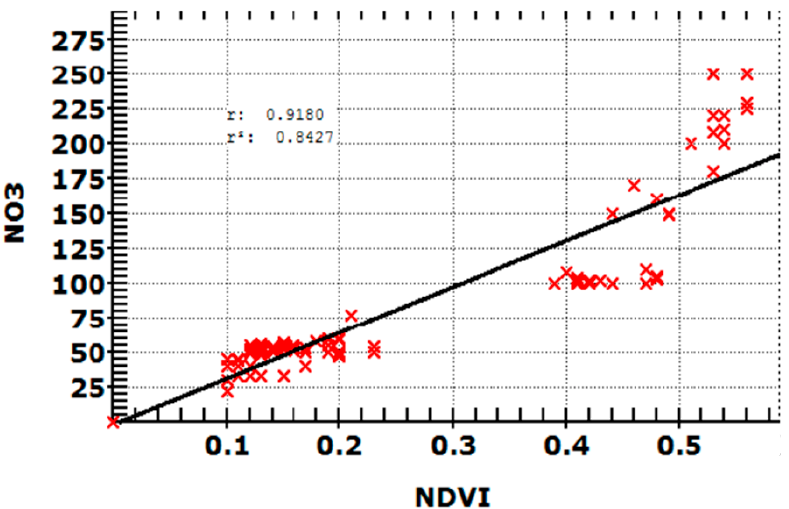
Figure 16. Relationship between NO 3 concentration in groundwater and calculated NDVI (r 2 =0.84) based on hydrological information collected from groundwater wells and NDVI calculated from satellite images.